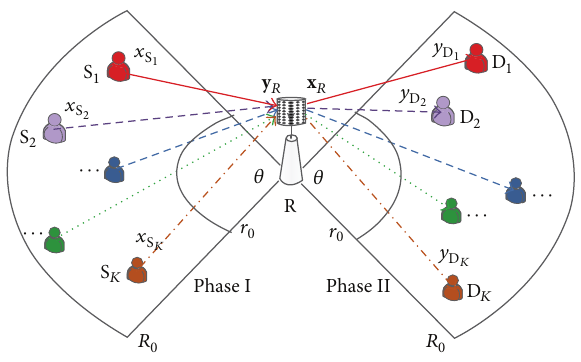
Figure 1: Relay system serving multiple pairs of nodes with massive